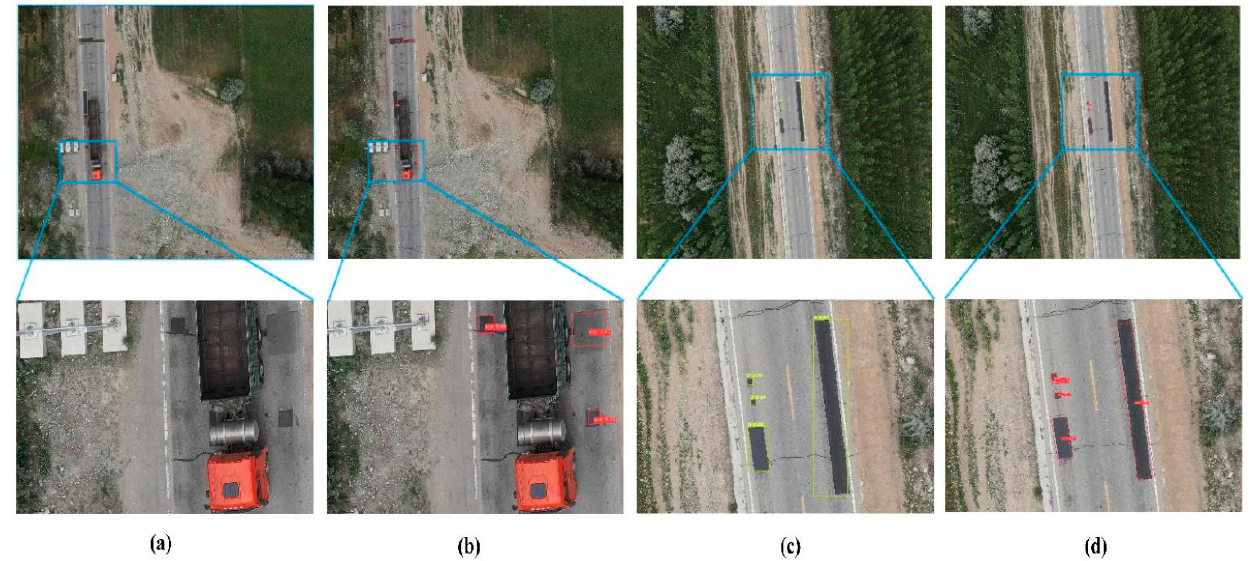
Figure 11. Comparison graph of algorithms for the same conditions of flight altitude. ( a , c ) Mo- bileNetv3 + YOLOv5s + CSL test results. ( b , d ) MR-YOLO test results.